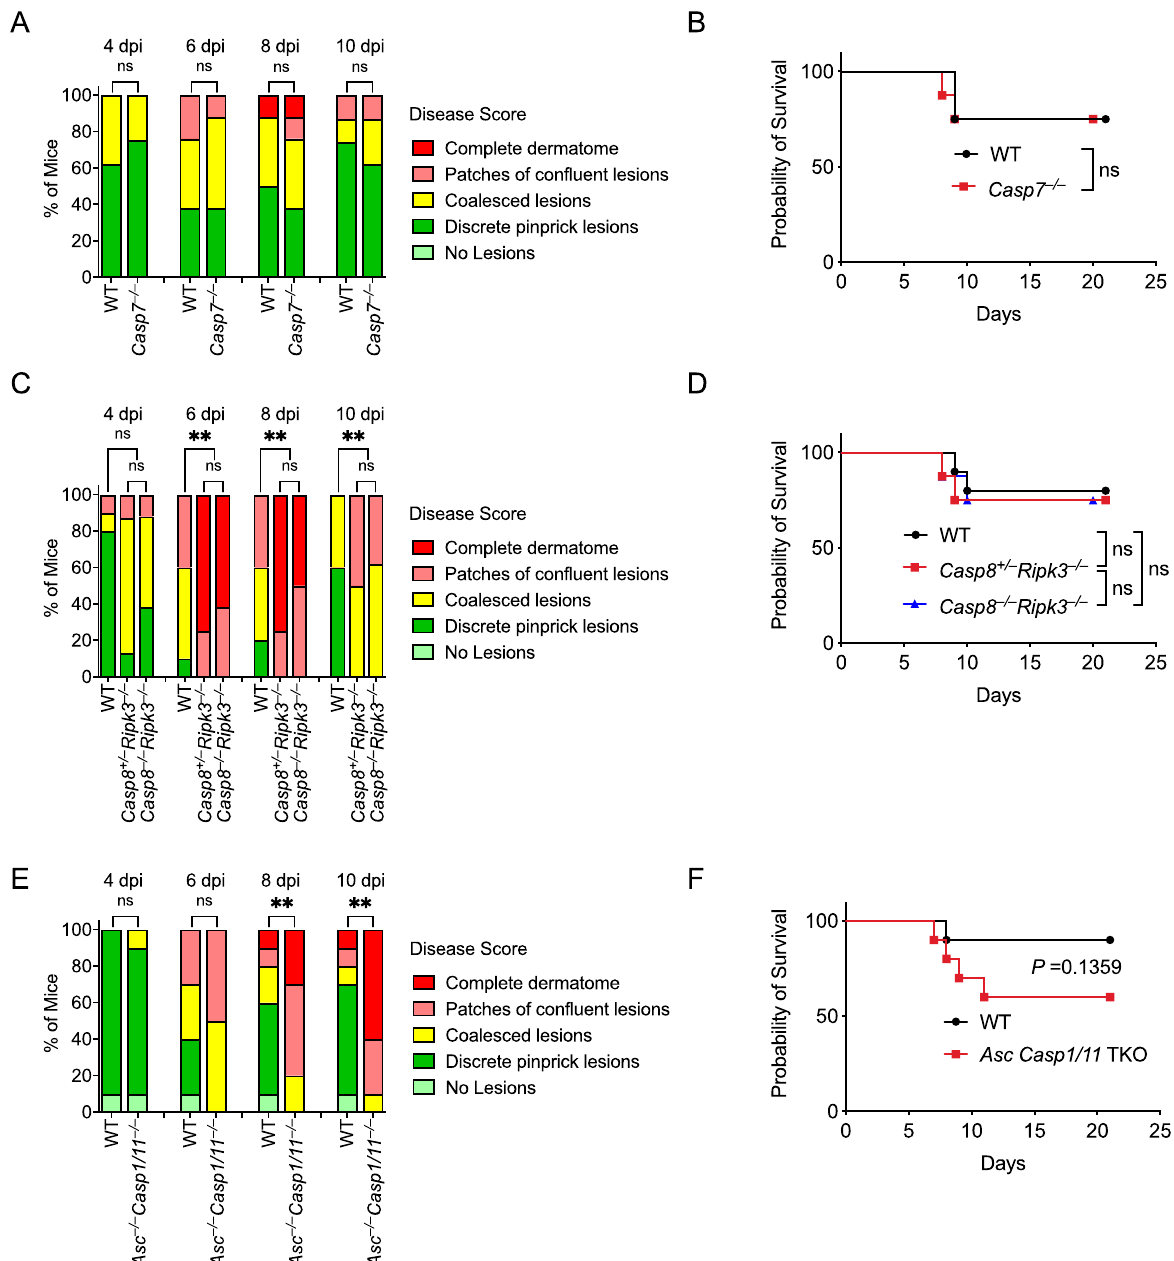
Figure 4. Caspase-7 and caspase-8 are not required to control HSV-1 skin infection, while ASC is protective in the absence of inflammatory caspases. Mice were infected at the right flank with 10 5 PFU HSV-1 strain NS. Disease scores ( A , C , E ) and survival ( B , D , F ) were monitored between WT and knockout mice. Mice number in: ( A , B ) WT n = 8, Casp7 –/– n = 8; ( C , D ) WT n = 10, Casp8 +/– Ripk3 –/– n = 8, Casp8 –/– Ripk3 –/– n = 8; ( E , F ) WT n = 10, Asc –/– Casp1/11 –/– n = 10. Data are pooled from two experiments ( A – F ). ns: not significant; ** p <